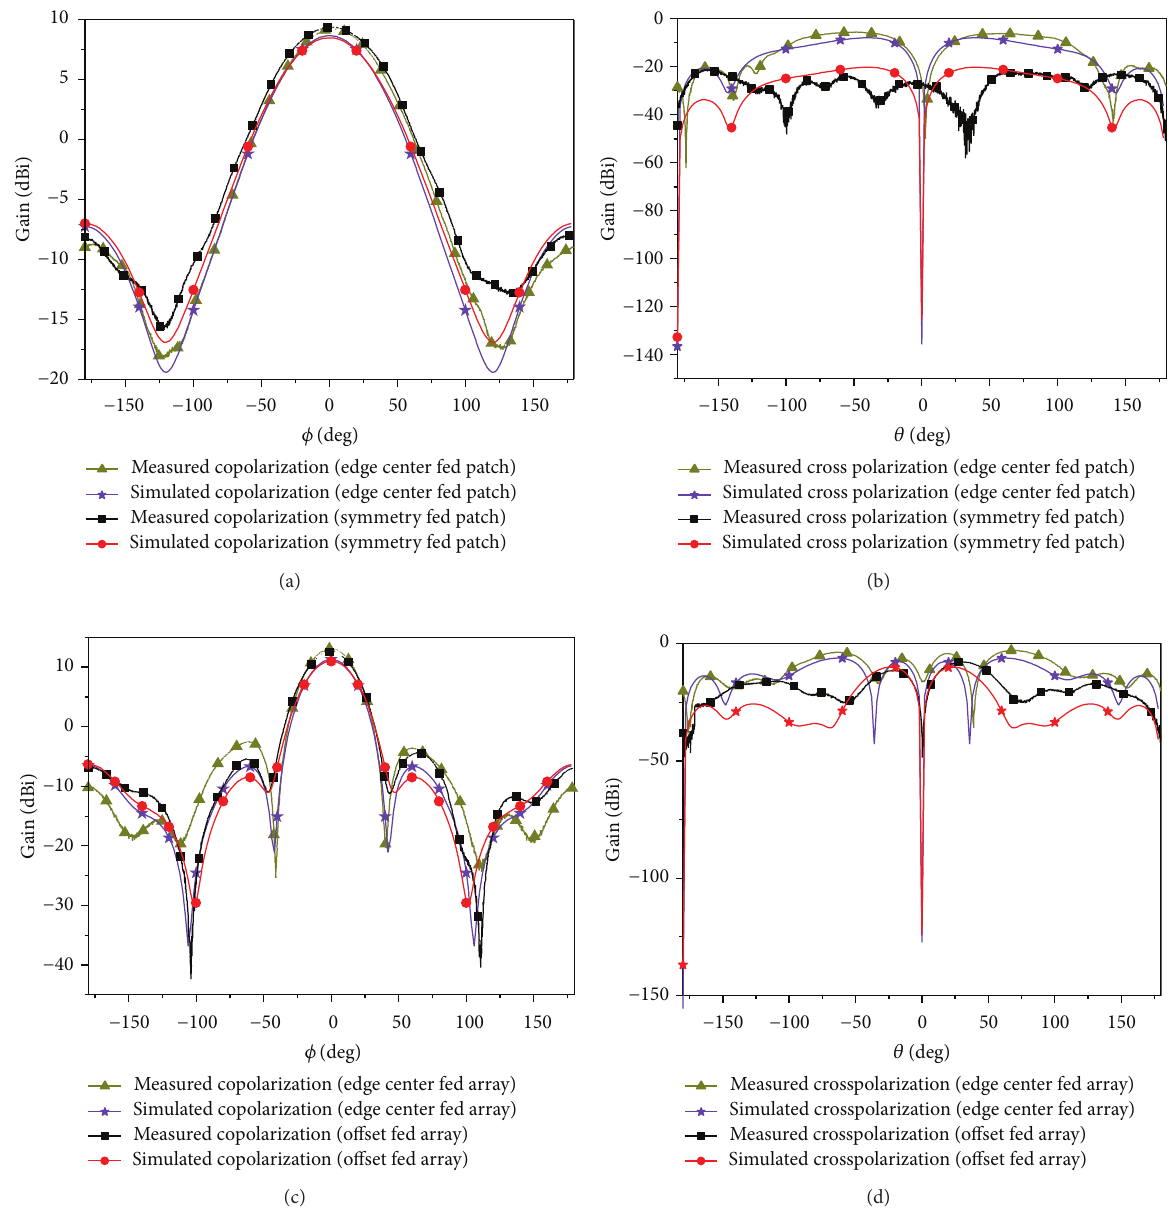
Figure 10: Simulated and measured radiation patterns of the antennas from Figure 7 in the xoz -plane (H-plane): (a) copolar and (b) cross- polar components of the patch antennas and (c) copolar and (d) cross-polar components of the patch arrays. Note that 𝑓 = 4.155 GHz for the symmetry offset fed patch antenna, 𝑓 = 4.43 GHz for the edge center fed patch array, and 𝑓 = 4.19 GHz for the symmetry offset fed patch